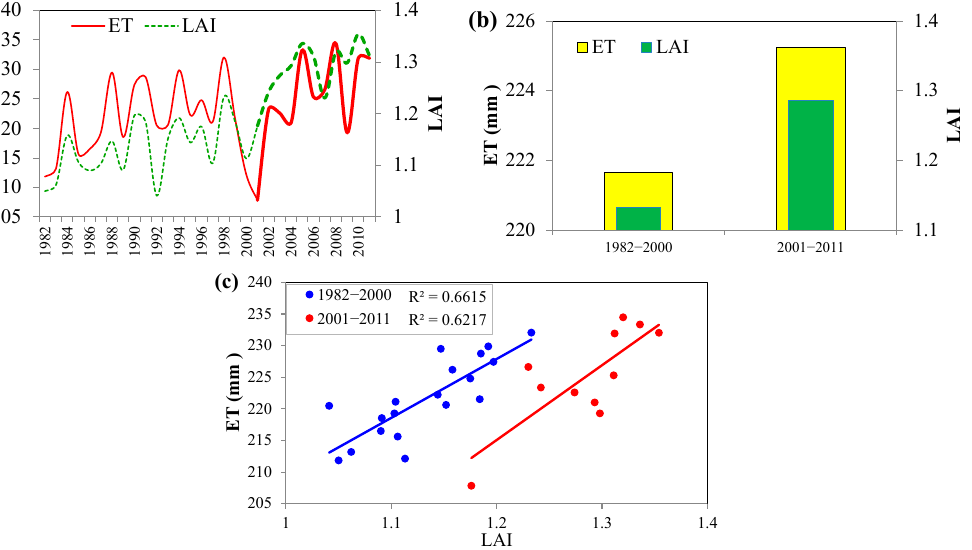
Figure 11. The changes in regional-mean summer ET and LAI on interannual ( a ) and interdecadal ( b ) scales, and their scatter plot ( c ).